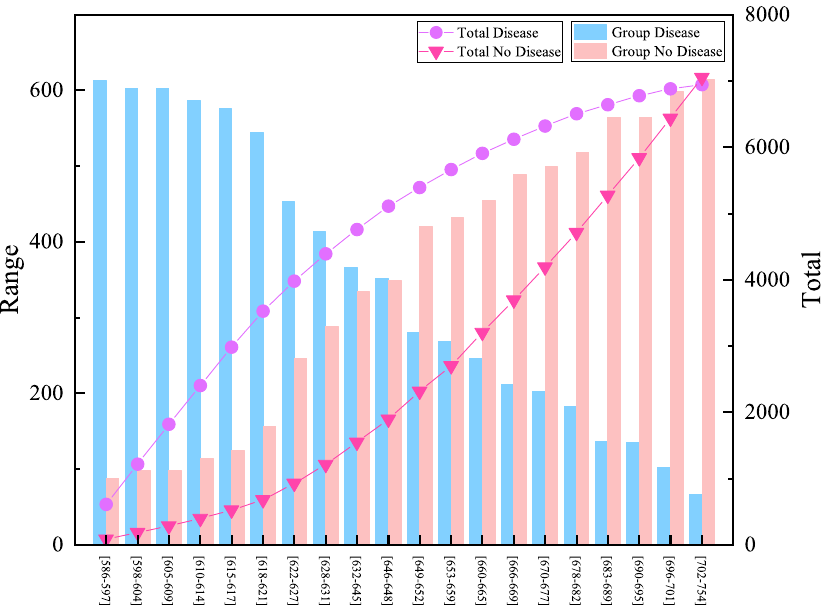
Figure 2. Scoring results and the number of patients. KS evaluates the risk discrimination ability of the model by measuring the difference between the cumulative distributions of good and bad samples. Greater than 0.3 indicates that the model has strong discriminative ability. The performance graph of the scorecard model is plotted according to the value of KS as shown in Figure 3. It can be seen from the table that the maximum KS value in group 9 indicates that this group has the best effect on distinguishing normal samples from diseased samples. The passing rate of about 95% is used as the criterion for whether or not to be sick, and the fractions correspond to [683, 689]. If the sample is lower than 683, it is judged to be sick, and further medical tests such as electrocardiogram and cardiac color ultrasound are required to achieve effective prevention and treatment for cardiovascular disease.